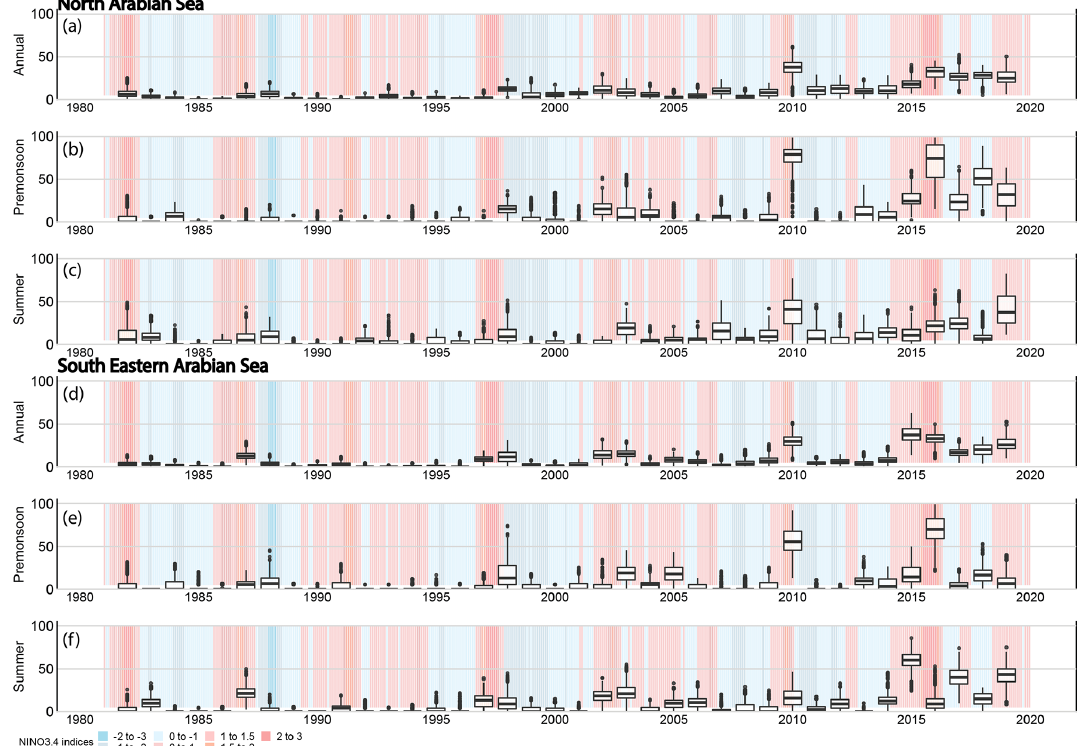
Figure 2. Boxplots representing the percentage of days experiencing heatwaves during (a and d) annual, (b and e) pre-monsoon, and (c and f) summer monsoon for the northern Arabian Sea (NAS) and the southeastern Arabian Sea (SEAS). The background shading represents the Niño3.4 index.